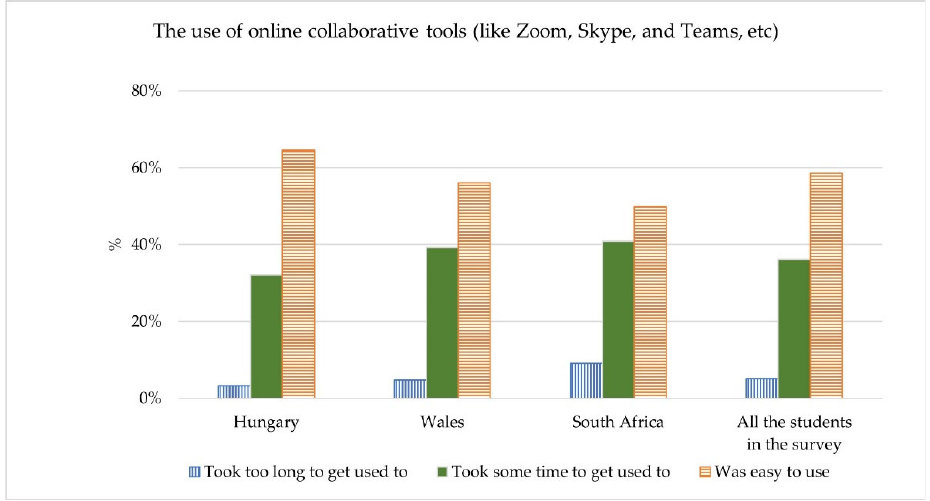
Figure 18. Student experience of online collaborative tools.